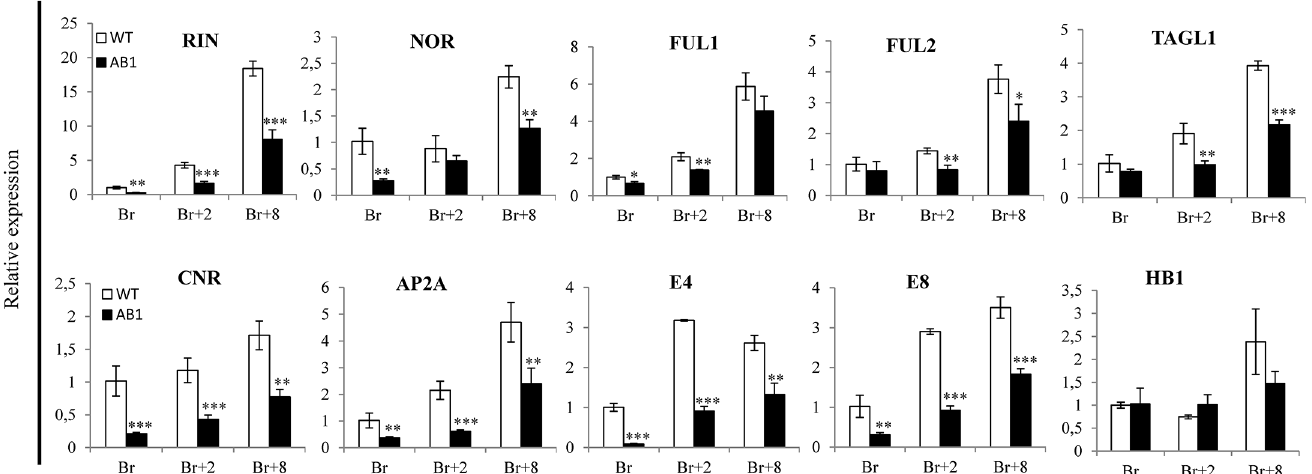
Fig 12. The expression of a number of ripening-related genes is altered in SlARF2AB-RNAi plants. Quantitative RT-PCR relative expression of ripening regulator genes in wild-type (WT) and SlARF2AB-RNAi lines during fruit ripening. Total RNA was extracted from the indicated developmental stages of fruit (breaker, Br; Br+2, 2 days post-breaker; Br+8, 8 days post-breaker). The relative mRNA levels of each gene in WT at the breaker (Br) stage were standardized to 1.0, referring to the SlActin gene as internal control. Error bar means ± SD of three biological replicates. Stars indicate statistical significance using Student ’ s t-test: * p-value < 0.05, ** p-value < 0.01. AP2a, APETALA2/ERF gene; CNR, colorless non-ripening; HB-1, HD-Zip homeobox; NOR, non- ripening; RIN, ripening inhibitor; TAGL1, tomato AGAMOUS-LIKE 1. FUL1, FUL2 MADS domain transcription factors; E4, E8 ethylene-responsive and ripening-regulated genes.